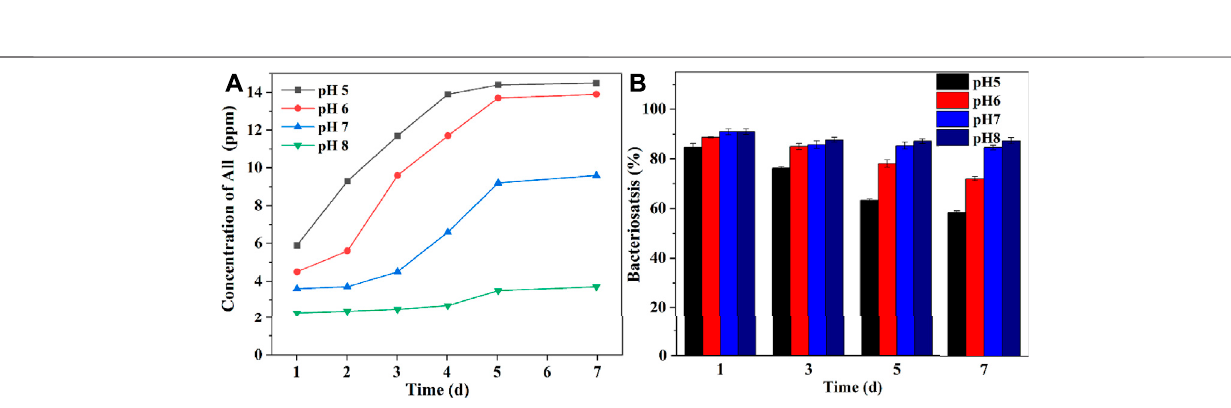
Frontiers in Materials |